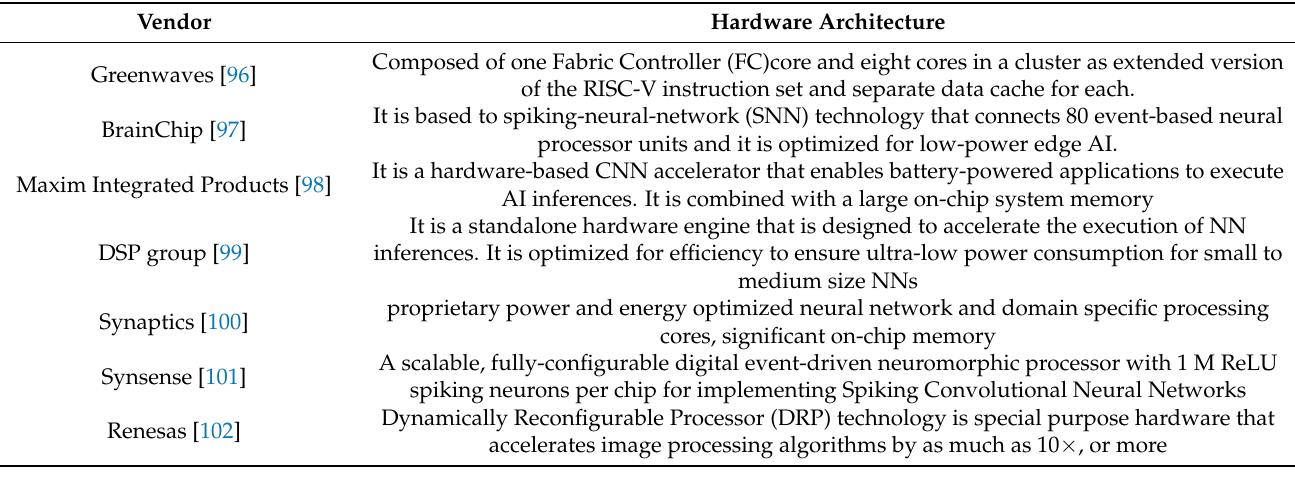
Table 3. Available AI/ML specialized accelerators as